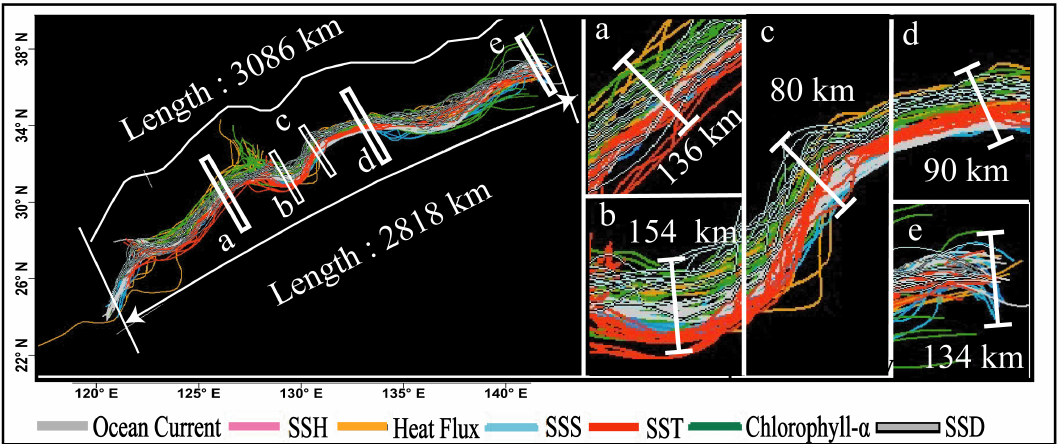
Figure 11. Kuroshio centerlines of all seven parameters to analyze the deviation from dominant path using five cross-sections at different locations where Kuroshio flows straight path ( a , c , d ), in ‘U’ shape ( b ) and its end point ( e ).